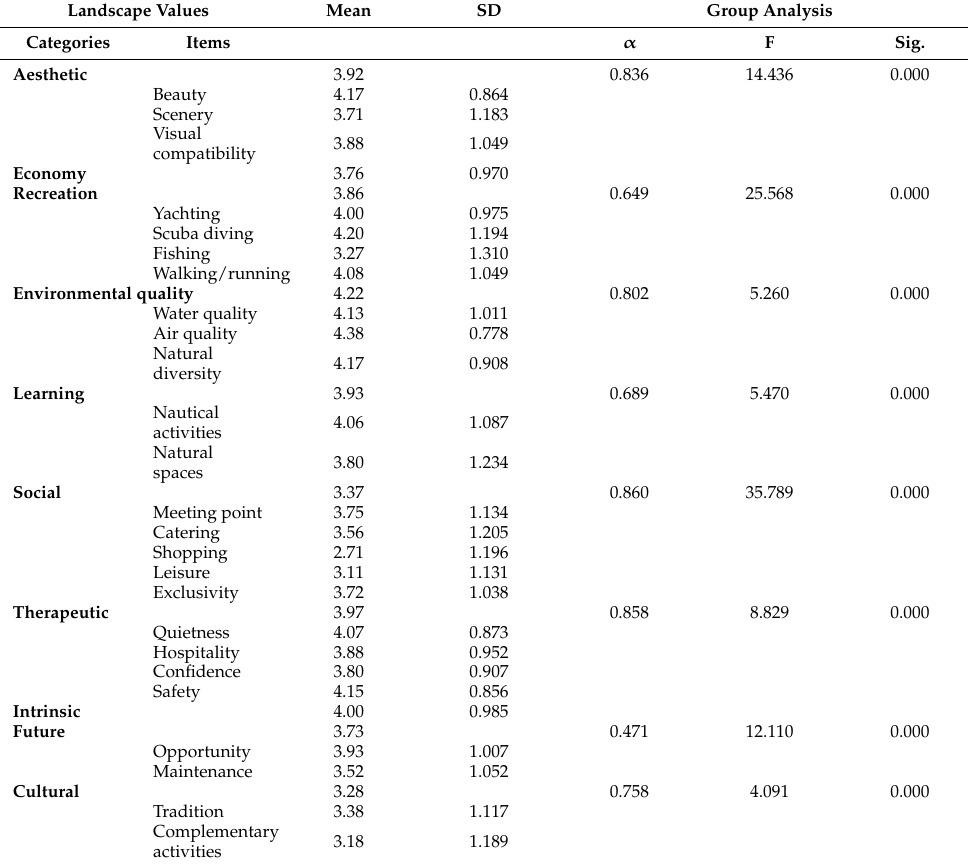
Table 4. Descriptive statistics for landscape